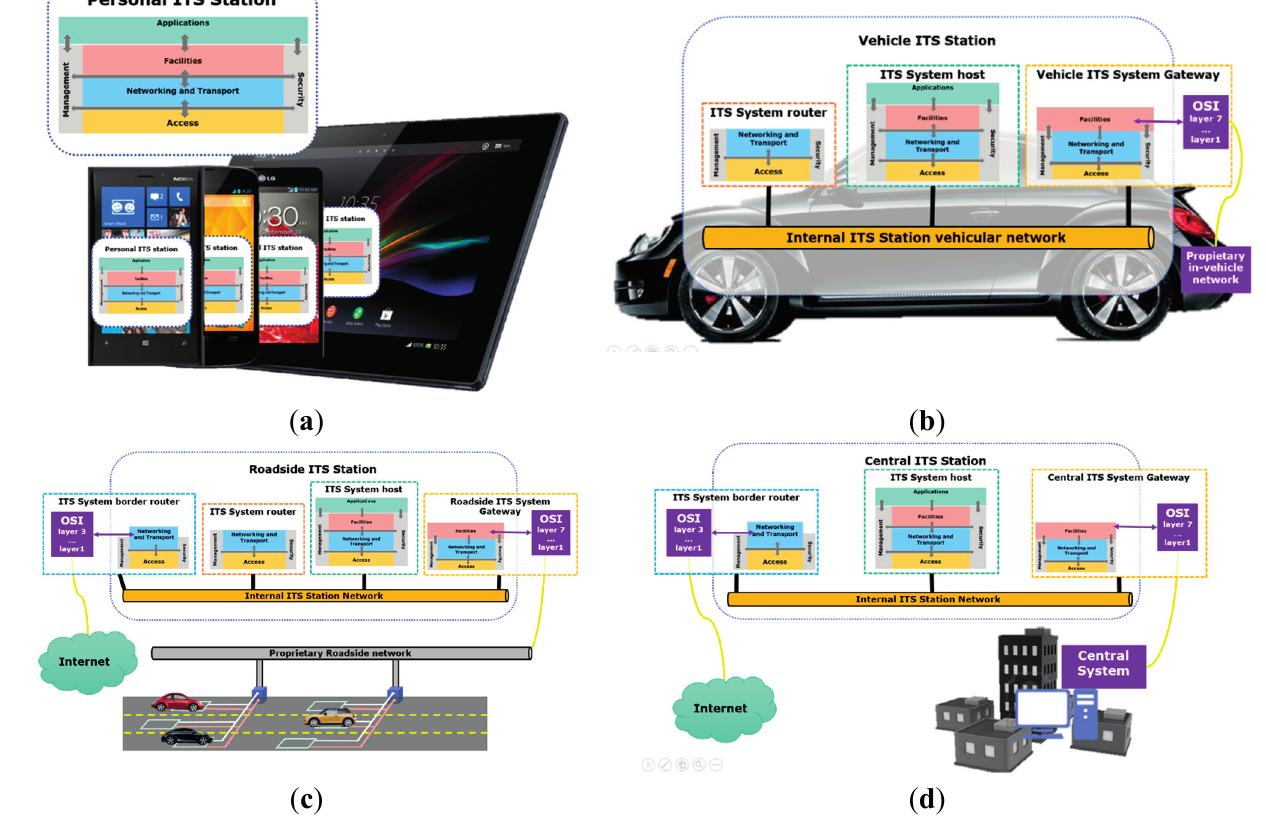
Figure 4. Existing ITS subsystems. ( a ) Personal ITS Subsystem; ( b ) Vehicle ITS subsystem; ( c ) Roadside ITS subsystem; ( d ) Central ITS